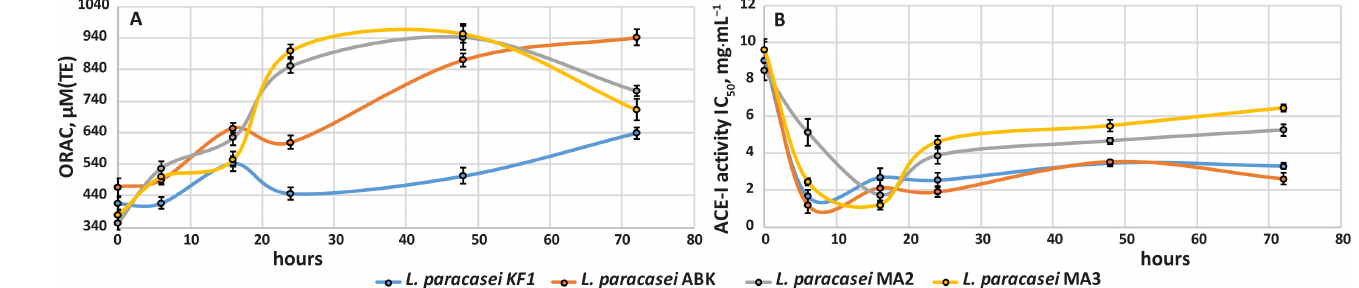
Figure 6. The development of antioxidant and ACE-I activities in the milk fermented by the kefir- derived (KF1 and ABK) and mahewu-derived (MA2 and MA3) strains of L. paracasei : ( A ) the devel- opment of antioxidant activity; ( B ) the development of ACE-I activity. The error bars represent the standard deviations from the mean.